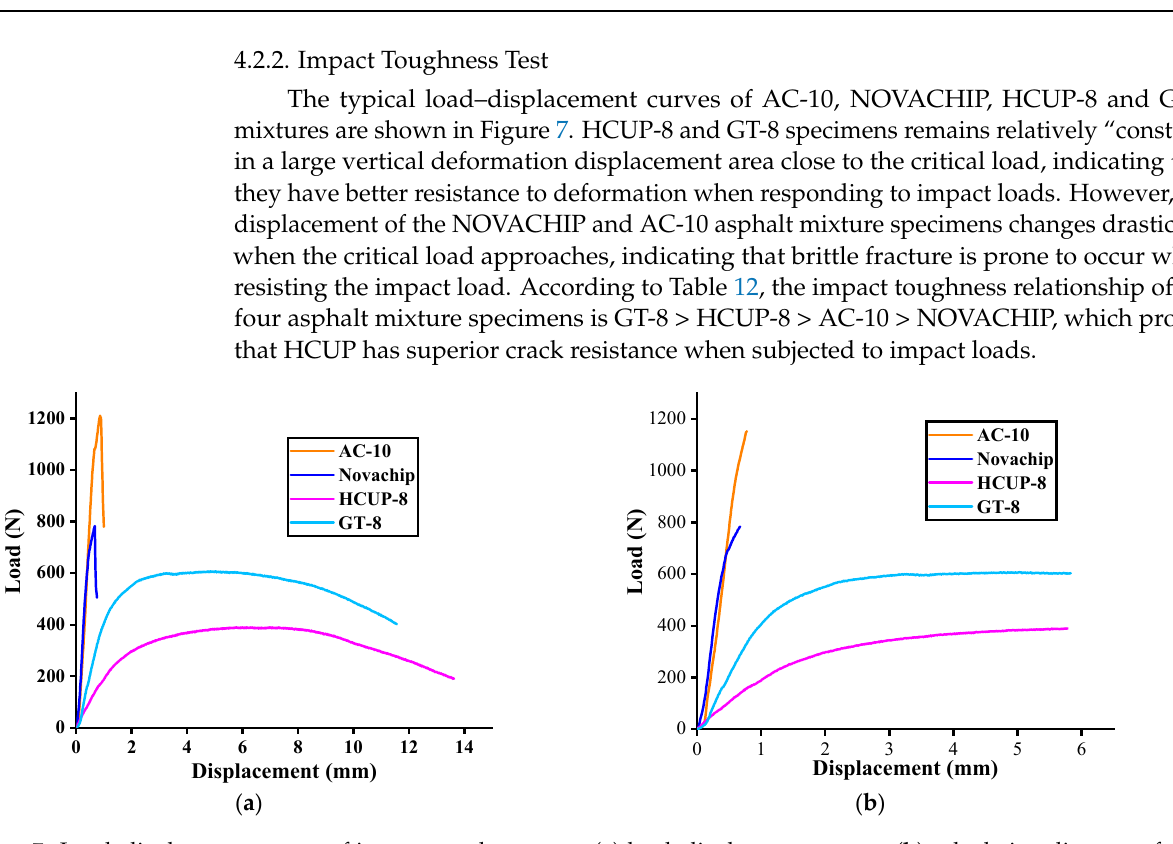
Table 11. Results of low temperature bending test.